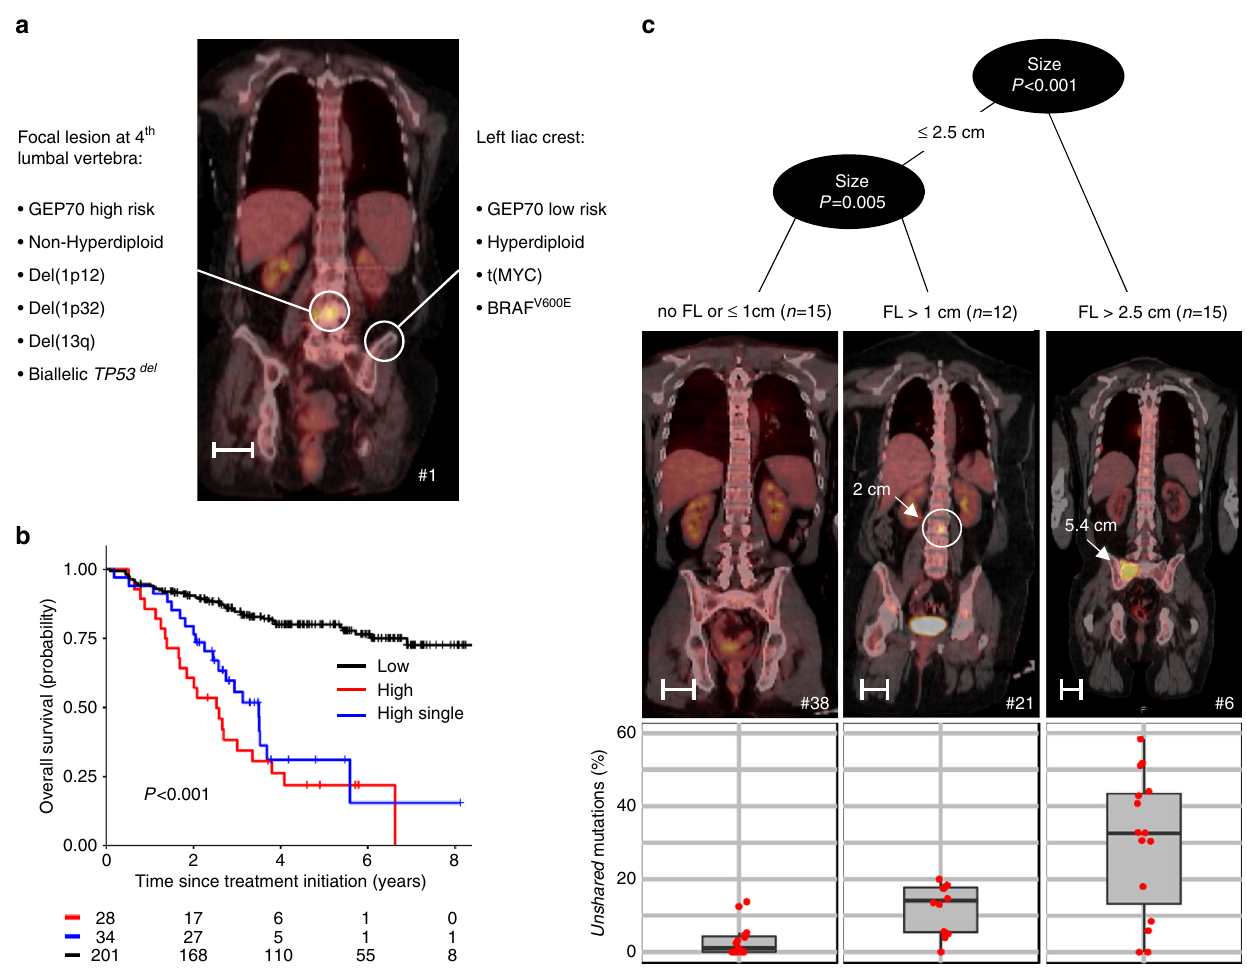
Fig. 3 Spatial heterogeneity: example, impact on outcome and association with the size of focal lesions. In a , unshared key drivers and the risk status in paired samples of patient no. 1 are shown. b Overall survival after enrollment into Total Therapy for 263 patients strati fi ed by the GEP70 risk status in a routinely collected iliac crest sample and a paired CT-guided fi ne needle aspirate. Whereas black and red indicate patients with GEP70 low- and high-risk in both samples, respectively, the blue line shows the outcome for patients with discrepancies for paired samples (single-site high-risk). In c , recursive partitioning with the maximum size of focal lesions as the predictor of the proportion of unshared mutations was performed. Representative PET-CT images for the three size-groups are depicted (length of scale bars = 5